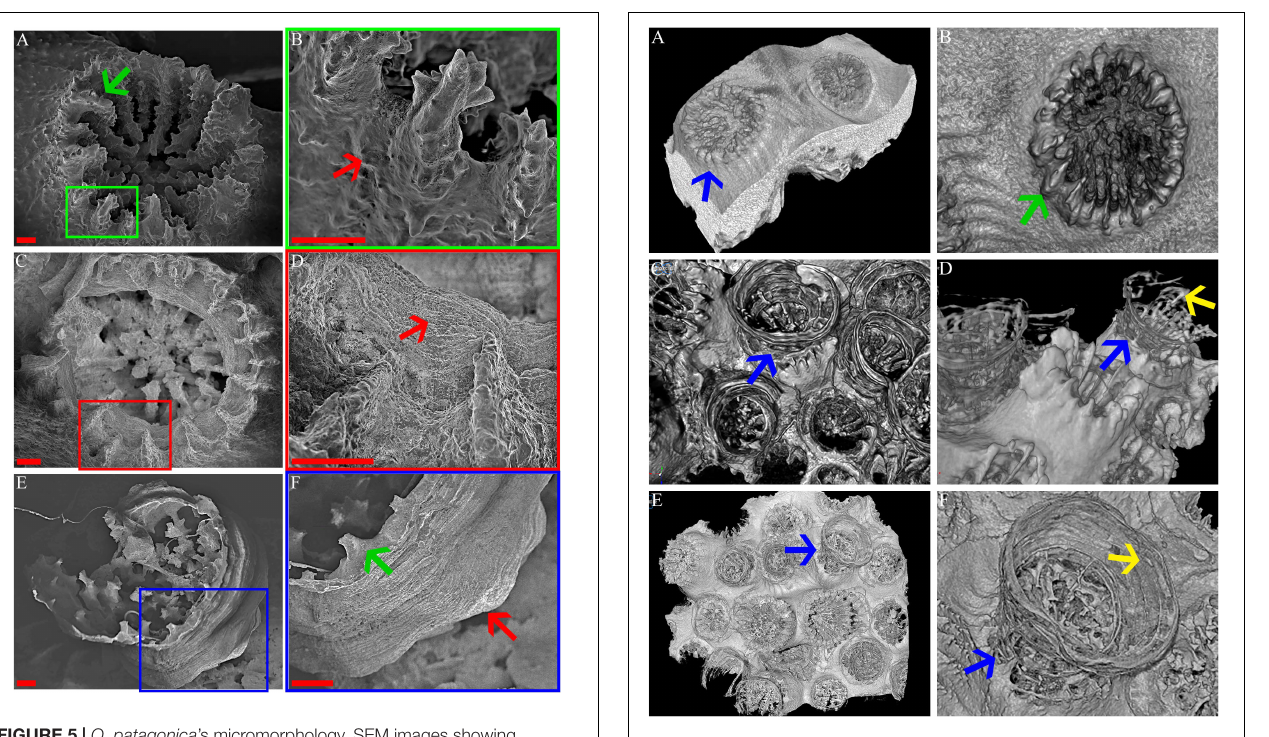
FIGURE 6 | Micro-CT. Micro-CT images showing O. patagonica micromorphology for ambient-light (A,B) and the dark samples at the 12 (C,D) and 18 (E,F) time points. Blue arrows identify the continuous vertical growth of the corallites in the dark samples (A,C–F) . Yellow arrows point to recurring internal bulges observed in the dark treated colonies (D,F) . Green arrow indicates regular costa formation in the ambient-light samples (B)